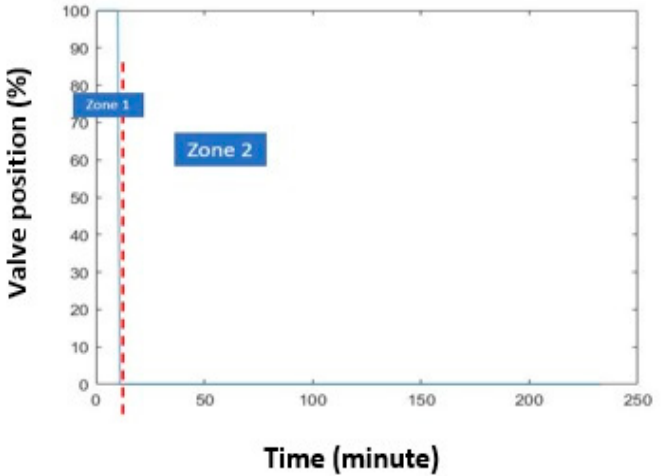
Figure 20. Valve position fluctuations in a theoretical classroom (measured values). Zone: It remarks different conditions during the experiments.